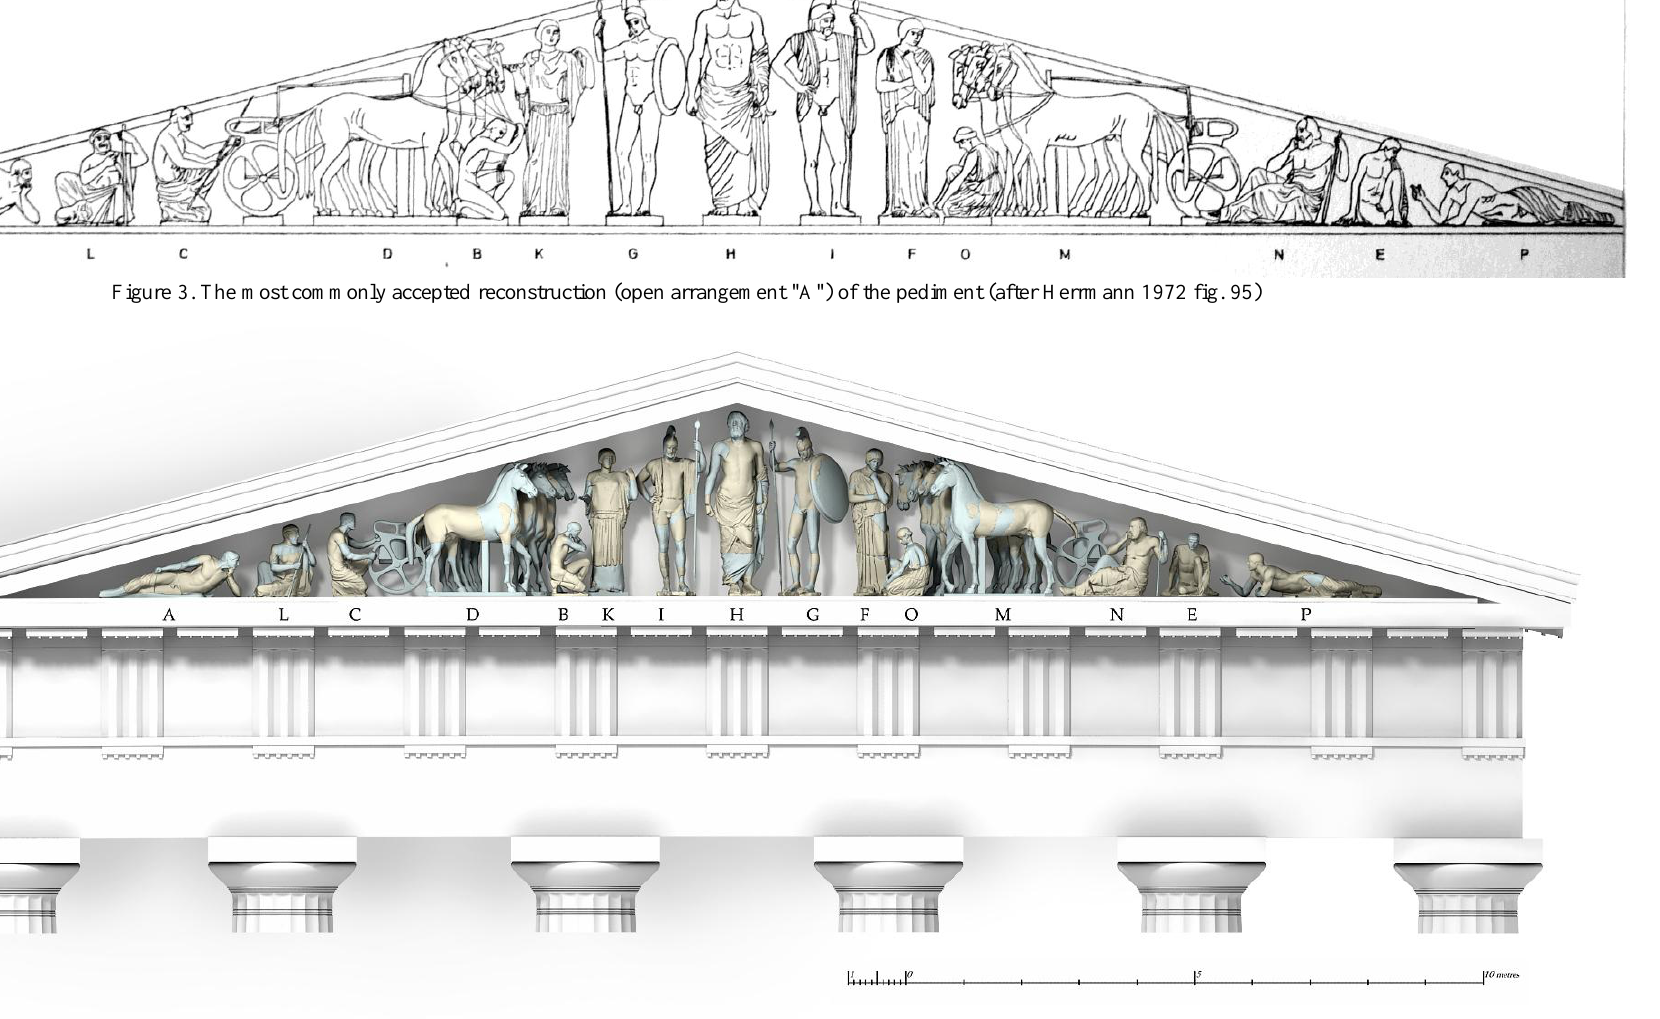
Figure 4. The new virtual reconstruction (closed arrangement "A") of the complete